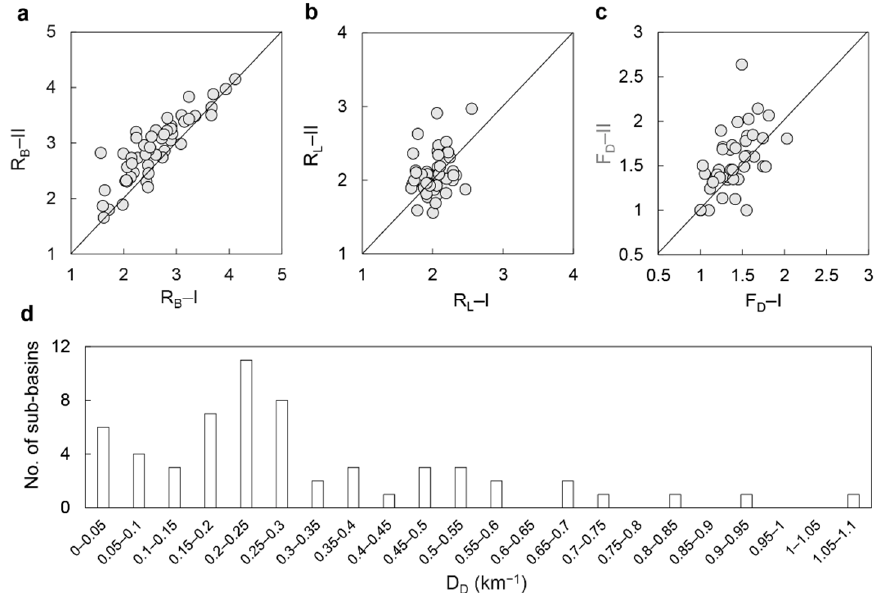
Figure 5. Distributions of river network parameters for endorheic sub-basins considered. Parameter space of ( a ) R B , ( b ) R L , and ( c ) fractal dimension index (F D ) estimated by regression method (I) and average method (II). ( d ) Frequency histograms of drainage density (D D , km − 1 ).